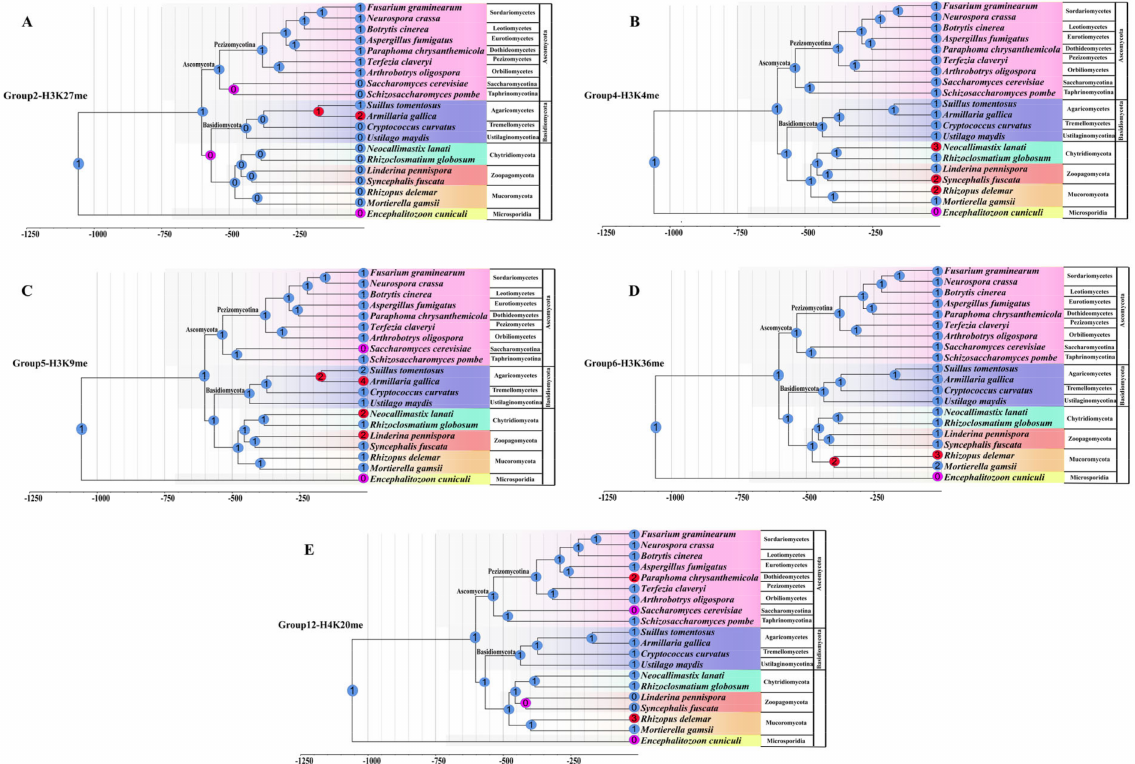
Figure 9. The evolution of five groups SET-domain genes analyzed with CAFE. Each tip of the tree represents a species. The numbers present on each node correspond to the number of SET-domain genes predicted by CAFE. Blue = No change; Red = Expansion; Purple =